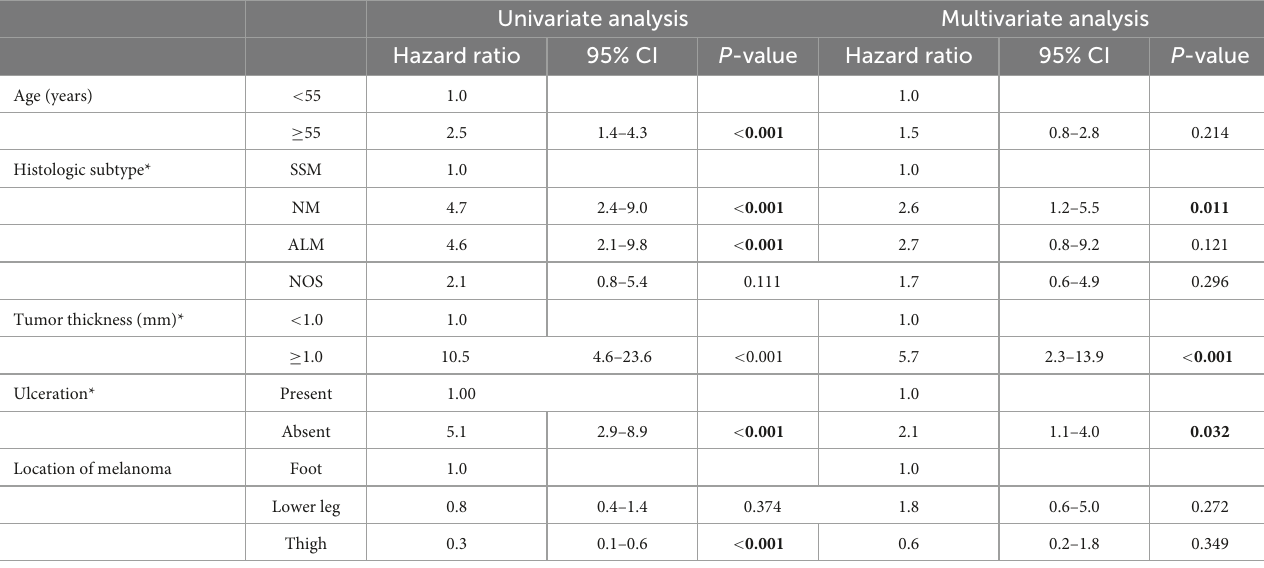
TABLE 2 Multivariate logistic regression analysis of risk factors for in-transit metastases of melanoma of the lower extremity.